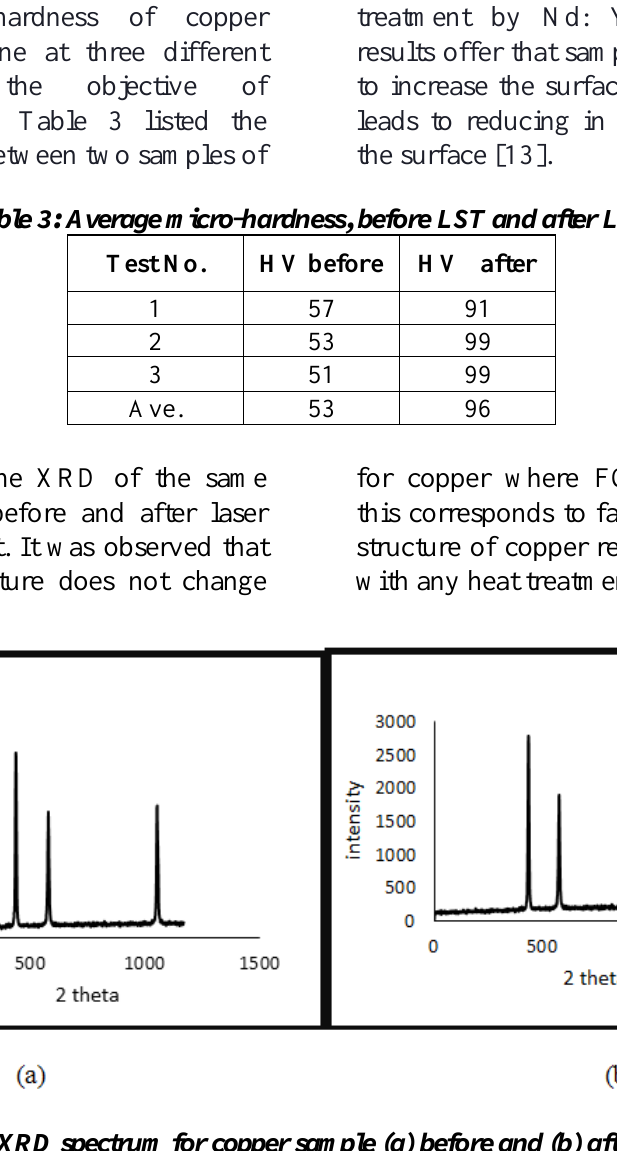
Fig.5: XRD spectrum for copper sample (a) before and (b) after